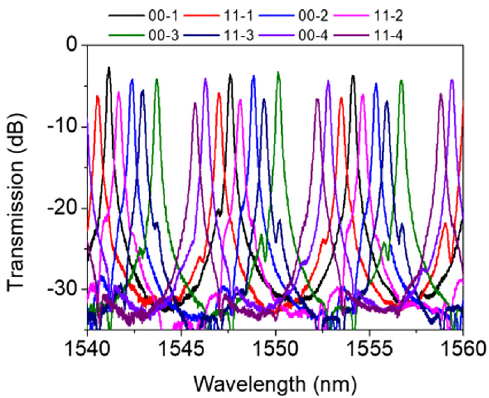
Figure 7: Measured transmission spectra of the cascaded four MMRRs for TE 0 and TE 1 mode input from 1540 to 1560